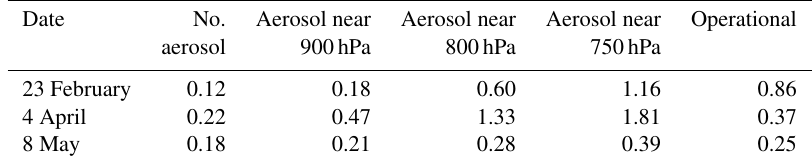
in the ECOSTRESS AU SAM site using different aerosol heights. 2